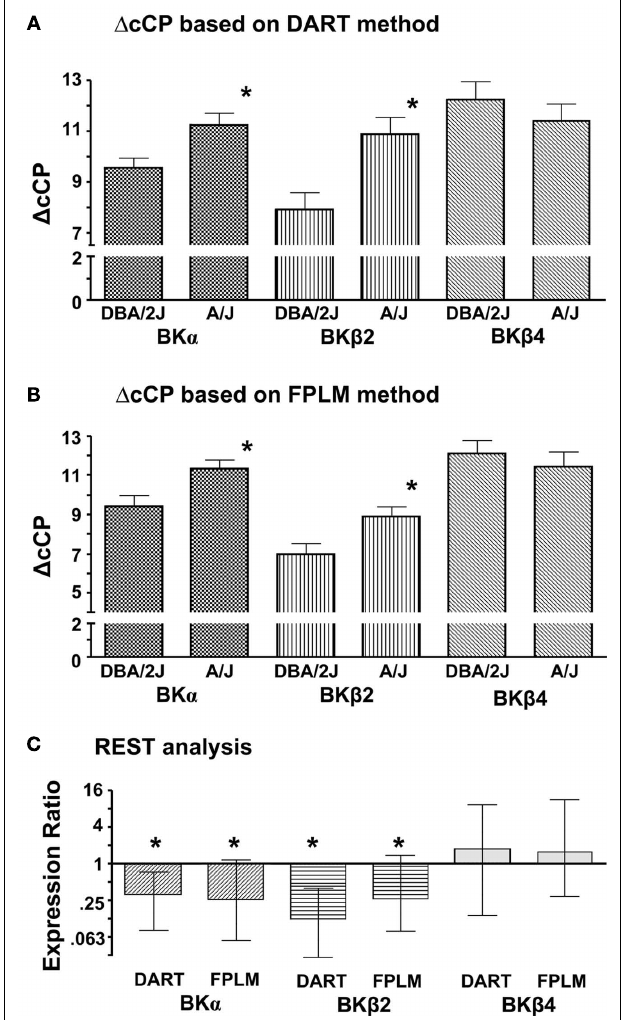
FIGURE 1 | Differences in the expression of BK channel subunits between the CB of the DBA/2J mice and the CB of theA/J mice. Individual cDNA samples were run in triplicates for each gene. A mean of the triplicates was calculated to represent a CP of a gene of a particular sample. Act was used as a reference gene. (A) Corrected CPs were obtained with the DART method. Δ cCP for each gene of a particular sample was calculated as (cCP gene − cCP Act ). Data are presented as mean ± SEM. ∗ , Significantly different from the samples of the DBA/2J mice (unpaired t -test, p < 0.05). Larger Δ cCP means the gene expression is lower. (B) Corrected CPs were obtained with the FPLM method. Δ cCP for each gene of a particular sample was calculated as (cCP gene − cCP Act ). Data are presented as mean ± SEM. ∗ , Significantly different from the samples of